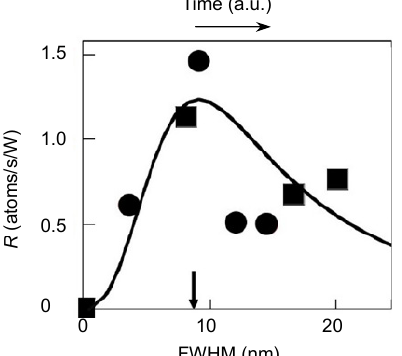
Fig. 2 | Dependence of the deposition rate R (atoms/s/W) on the FWHM of the Zn-NM. FWHM increased with increasing deposition time. The number of atoms deposited per unit time was normalized to the irradiated light power ( W ) to derive the rate R . The wavelength of the propagating light for creating the DP was 325 nm. Closed circles and squares represent the measured values when the powers of the light incident to the fiber probe were 5 μ W and 10 μ W, respec- tively. The downward arrow represents the value of 2 a p